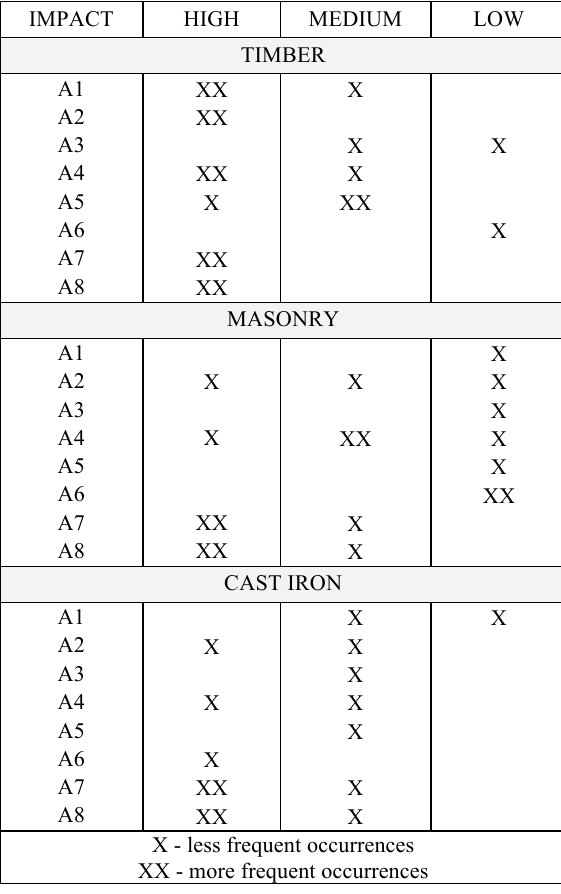
Table 3. Influence of long-term impacts on structural